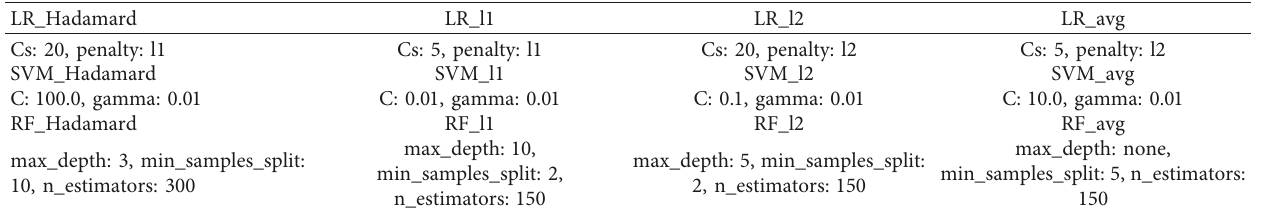
Figure 2: FromMarch11untilMay26in2021,cumulativeprobabilitydistributionofdegreeinreplying(a),retweeting(b),andquoting(c)interactions. Table 3: Utilizing the obtained embeddings through Node2Vec, best hyperparameters for LR, SVM, and RF models for replying interaction from March 12 until April 12 in 2021 1 .